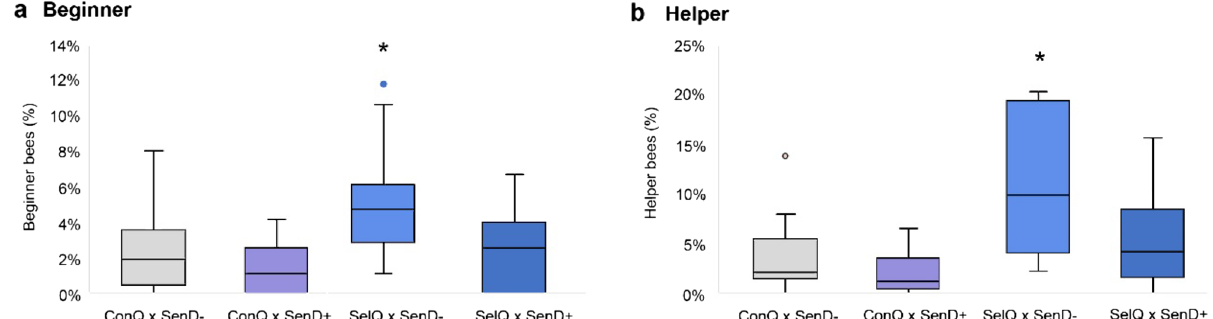
Figure 3. Boxplot of beginner and helper bees in groups based on the drones’ olfactory sensitivity. Displayed are median, standard deviation and outliers for the beginner ( a ) and helper ( b ) categories for each group. The proportions of beginner ( a ) and helper ( b ) bees during the three courses of the video observation experiment are displayed for each group. One colony had 11.8% beginner bees (outlier—group SelQ × SenD− ). One colony exhibited 13.8% helper bees (outlier—group ConQ × SenD− ). The number of colonies tested per group was as follows: 11 ( ConQ × SenD− ), 8 ( ConQ × SenD +), 9 ( SelQ × SenD− ) and 12 ( SelQ × SenD +). *Proportion of